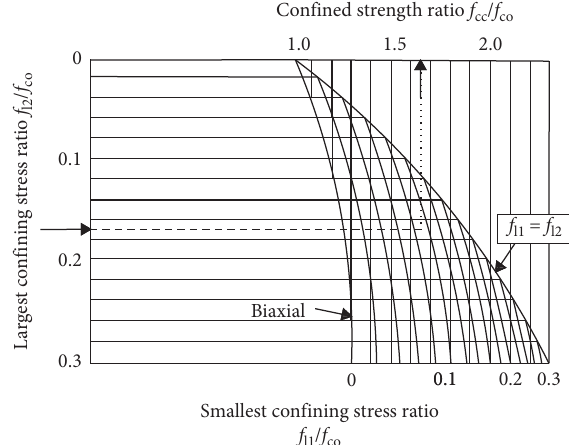
Figure 9: Relationship between the effective lateral confining stresses and strength of the confined concrete for rectangular